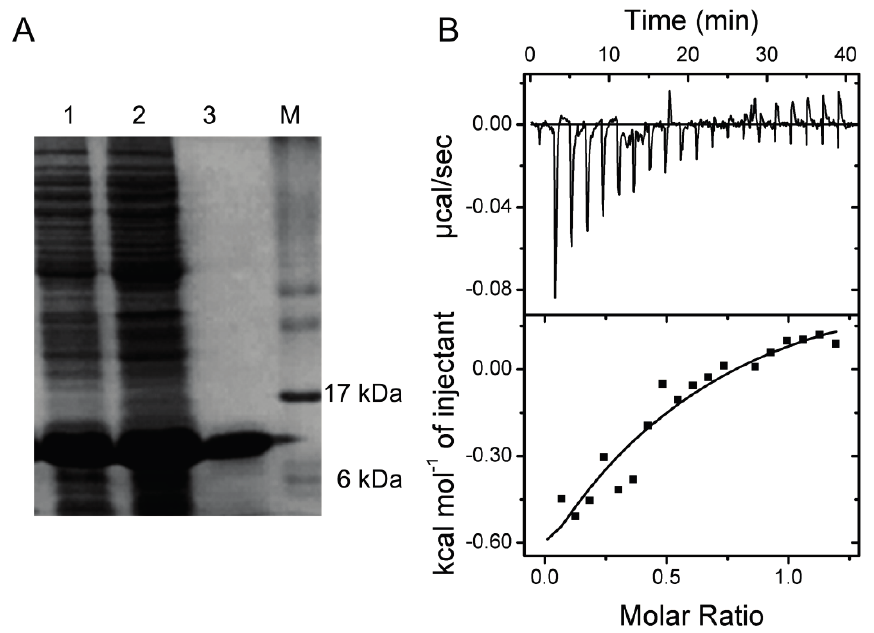
Figure 6. ( A ) SDS-PAGE image showing the purification of Tub-C by Ni 2+ affinity chromatography. Lane 1, cell lysate; Lane 2, elutes with 60 mM imidazole from the column; Lane 3, elutes with 0.5 mM imidazole from the column, corresponding to purified Tub-C; ( B ) Isothermal titration calorimetric analyses of the binding of Tub-C to SelP-H. Top : raw data; Bottom : plot of integrated heat versus Tub-C/SelP-H molar ratio. The solid curve represents the best fit with sequential binding